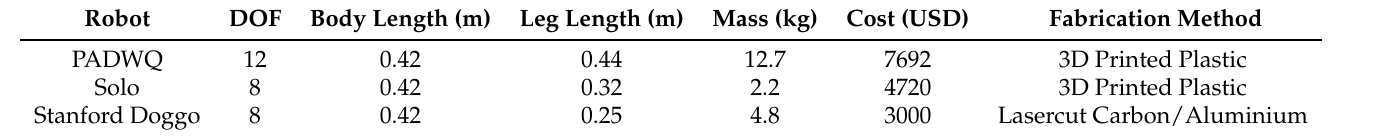
Table 6. Comparison of Current Open-Source Torque Controlled Quadrupeds.